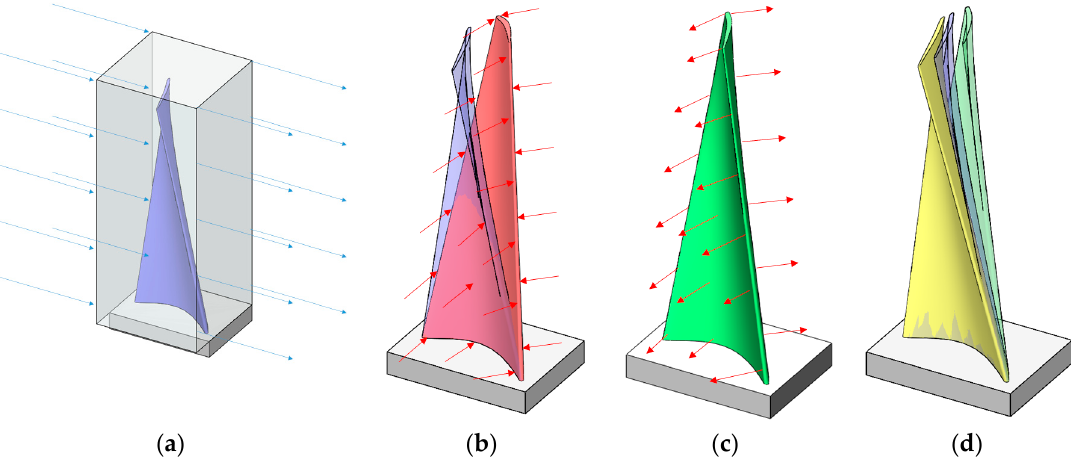
Figure 2. Process of obtaining a new cold shape. ( a ) Flow field around the cold shape; ( b ) aerodynamic load acting on the hot shape; ( c ) aerodynamic load reversely applied to the ideal shape; ( d ) new cold shape.